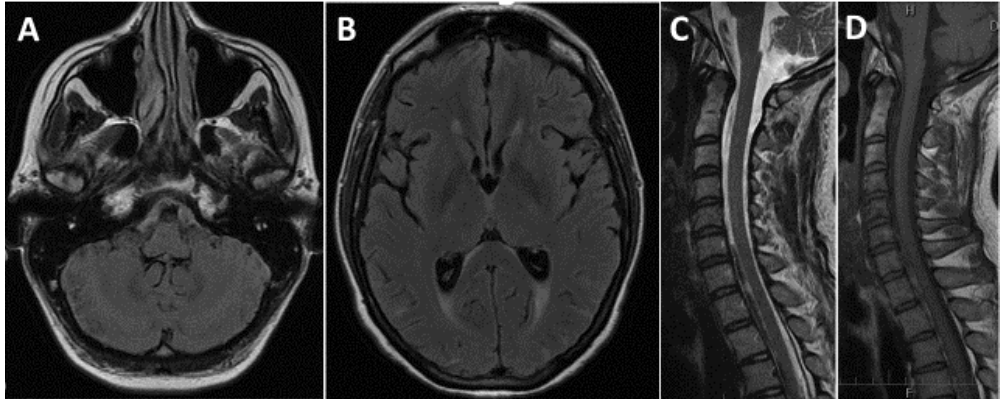
Figure 1. Initial MRI, subarachnoid hemorrhage. ( A ) Axial FLAIR image, premedullary subarachnoid hemorrhage (SAH). ( B ) Axial FLAIR image, SAH on the posterior convexity. ( C ) Sagittal T2—weighted image, premedullary SAH. ( D ) Sagittal T1—weighted image, premedullary